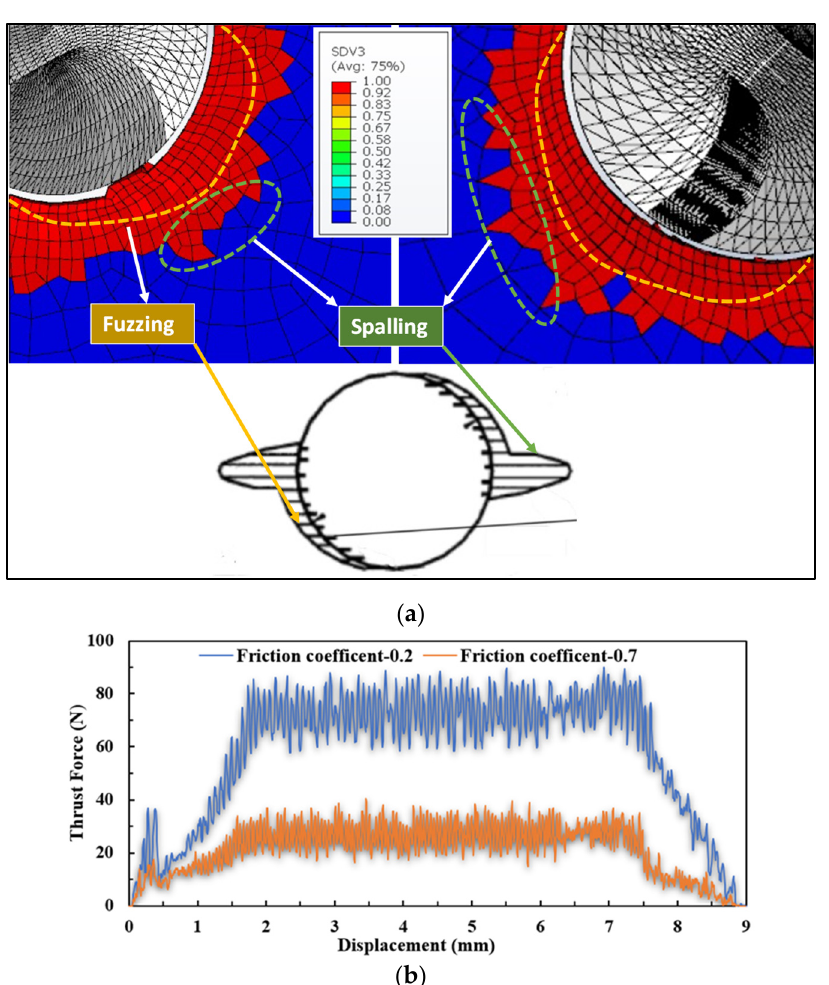
Figure 7. Comparison of ( a ) fuzzing and spalling damage (Right) µ = 0.7 (Left), µ = 0.2 (right) and ( b ) thrust profiles at different friction coefficients.